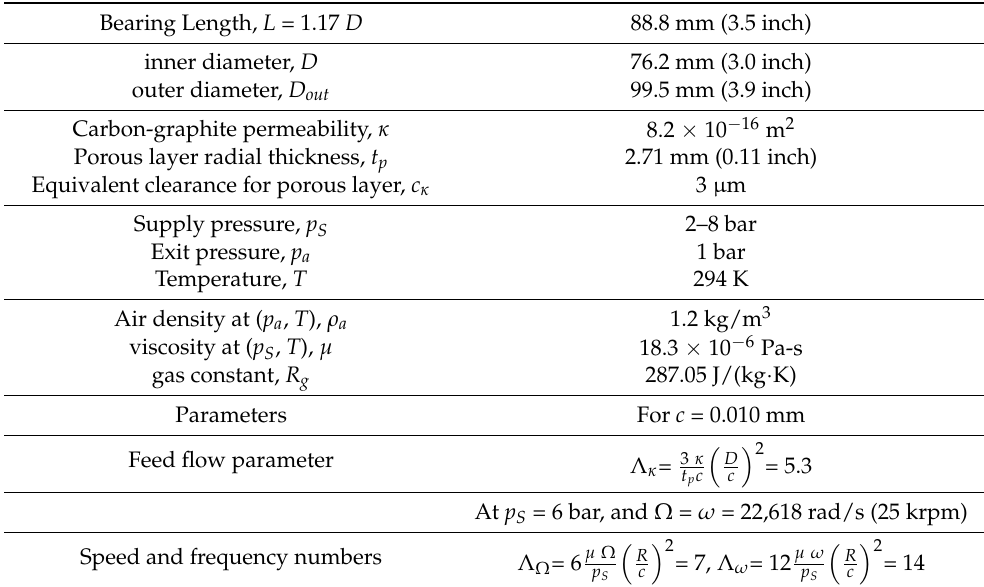
Figure 2. Photograph of a porous material cylindrical journal bearing. Table 1. Dimensions of porous journal bearing and operating